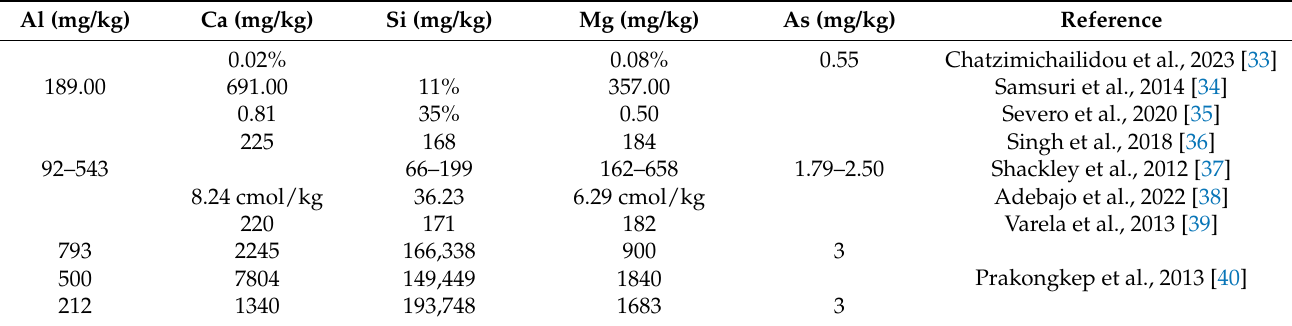
Table 1. Characteristics and partial elemental composition of rice husk